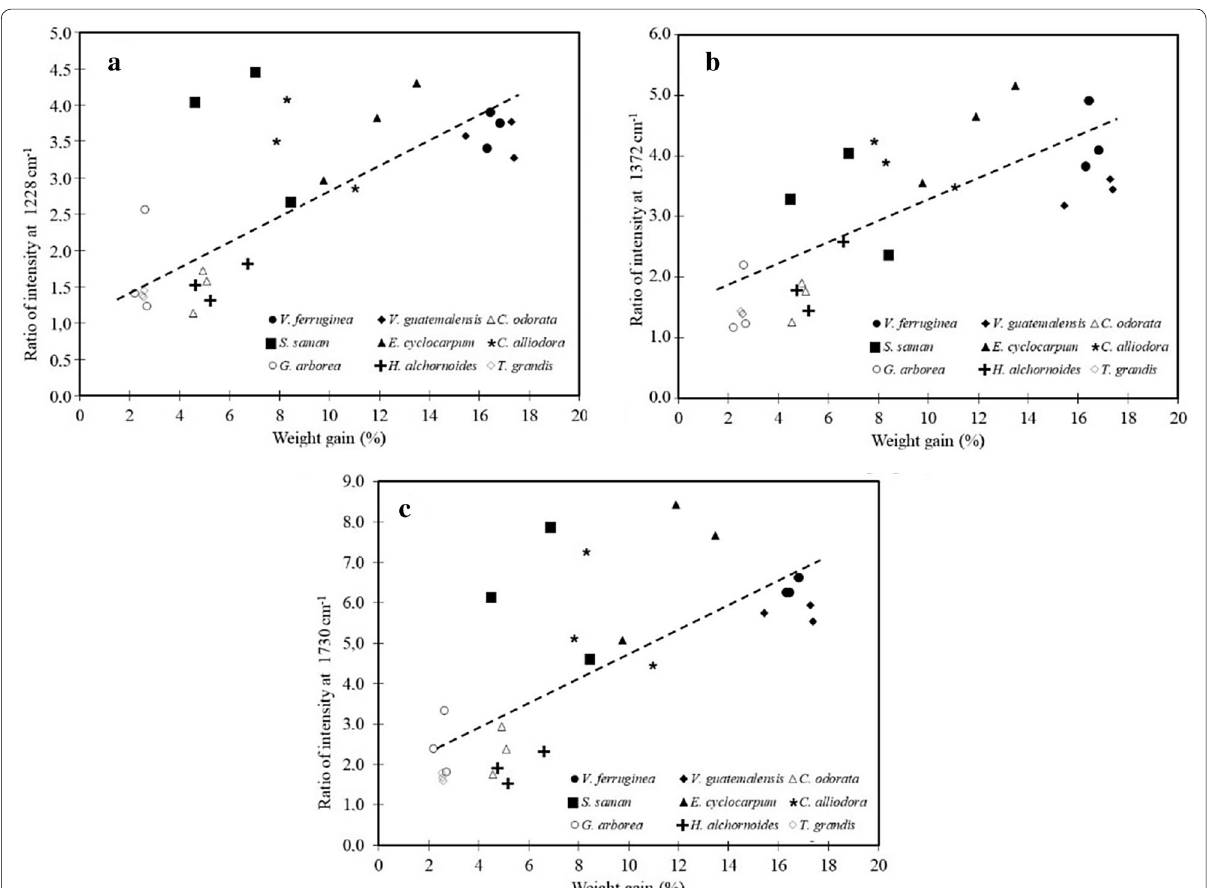
Fig. 3 Correlation of ratio of intensity of the absorbance at 1228 ( a ), 1372 ( b ) and 1732 ( c ) cm − 1 in FTIR spectra of acetylated tropical hardwoods modified in different acetylation